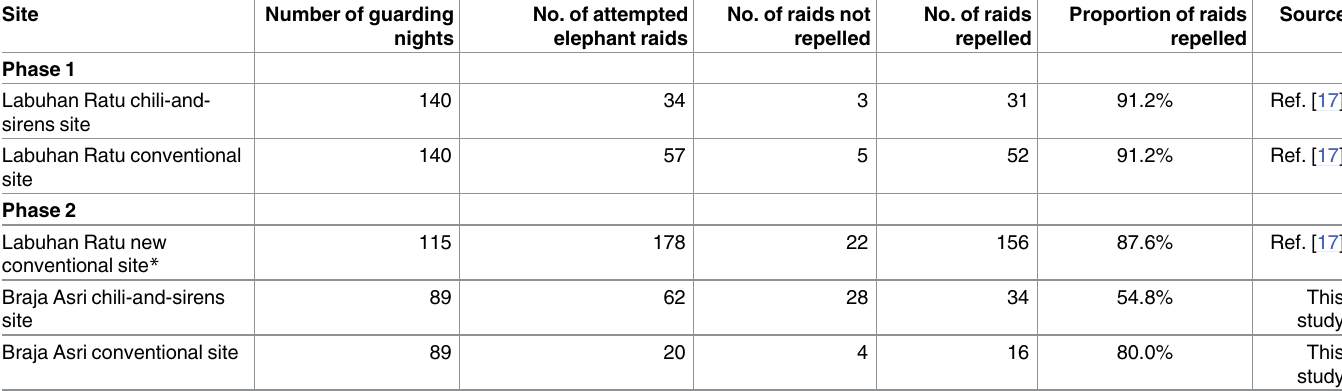
Table 4. Comparison of the effectiveness of the two different crop protection systems tested: Community-based crop-guarding with conventional tools (at the ‘conventional’ sites) and community-based crop-guarding with chili-grease fences and trip-wire triggered sirens (the ‘chili-and- sirens’ sites) in Phases1 and